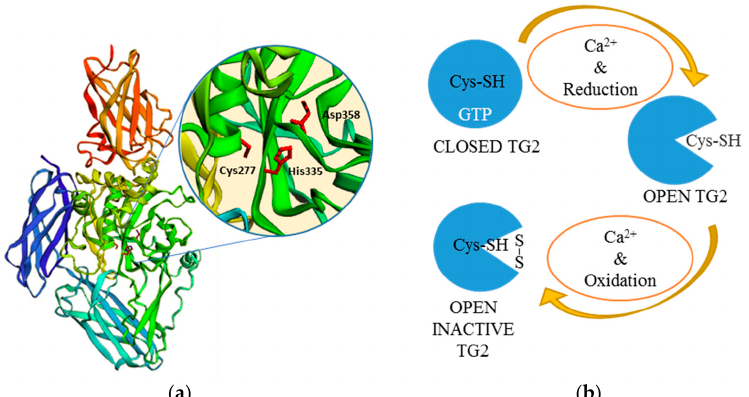
Figure 2. Human transglutaminase 2 (hTG2) structure and regulation. ( a ) hTG2 structure is shown in closed conformation. The catalytic site is composed by the triad, Cys277, His335, and Asp358. In this conformation, the protein is inactive, since the two β -barrels hide the catalytic pocket. Three-dimensional structure (PDB: 4PYG) was produced with the molecule modelling software, “EzMol” (version 1.22) [34]. ( b ) Effect of redox regulation on TG2 conformations. TG2 is locked in closed conformation when bound to guanosine triphosphate (GTP) and calcium concentration is low. Conversely, it assumes an open conformation after calcium binding, which can either be inactive when in oxidising conditions or active in reducing conditions